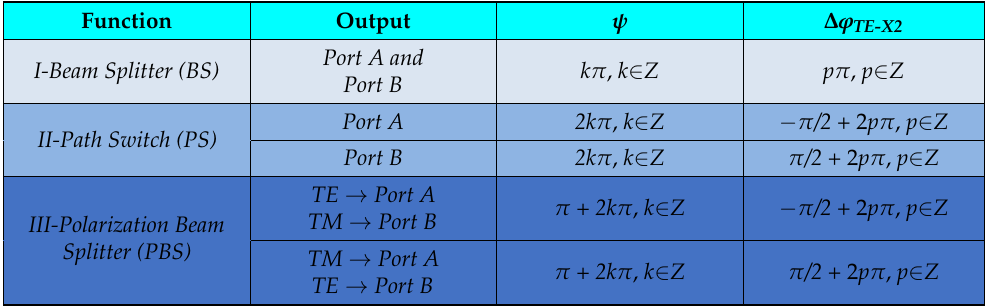
Table 1. The phase configuration for different device function: polarization independent beam splitter (BS), path switch (PS), and polarization beam splitter (PBS). p and k are both numbers from the integer set Z